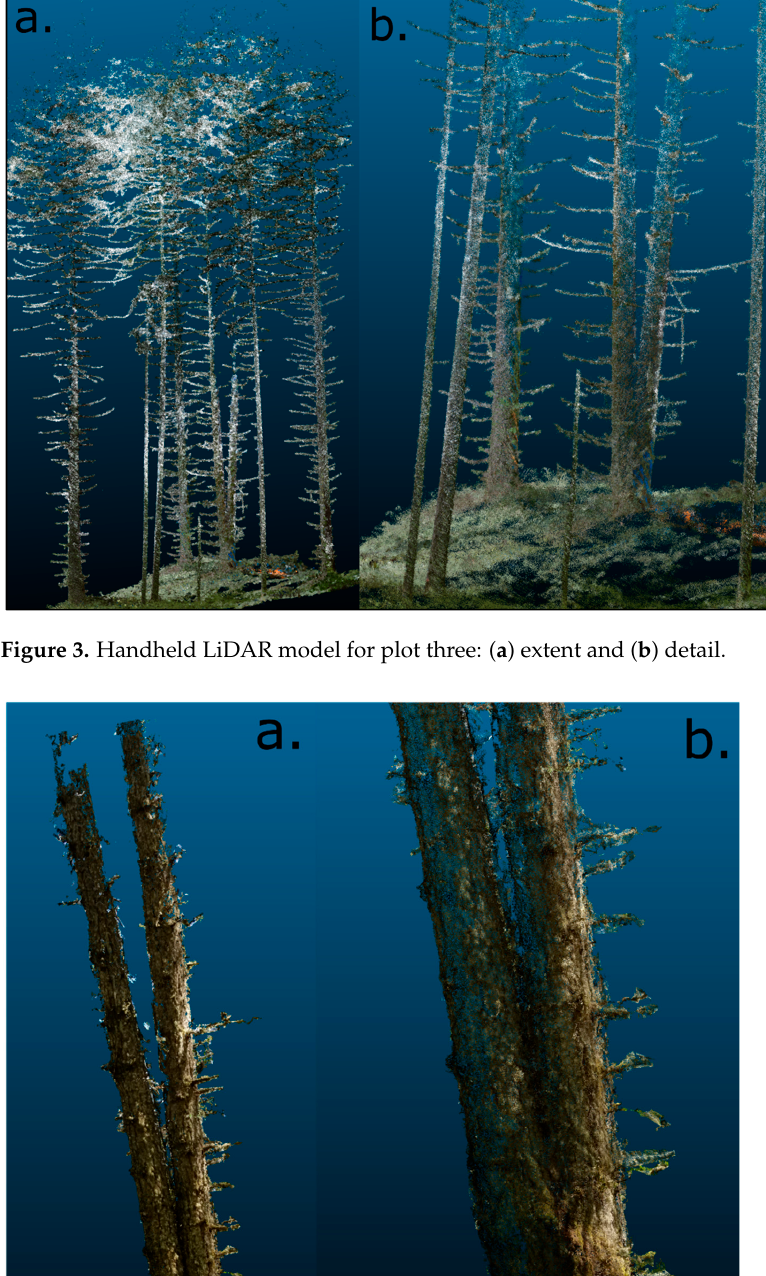
Table 4. Mean point cloud density from handheld LiDAR and Structure from Motion (SfM) photo- grammetry of three, 400 m 2 fixed-radius forest inventory plots.